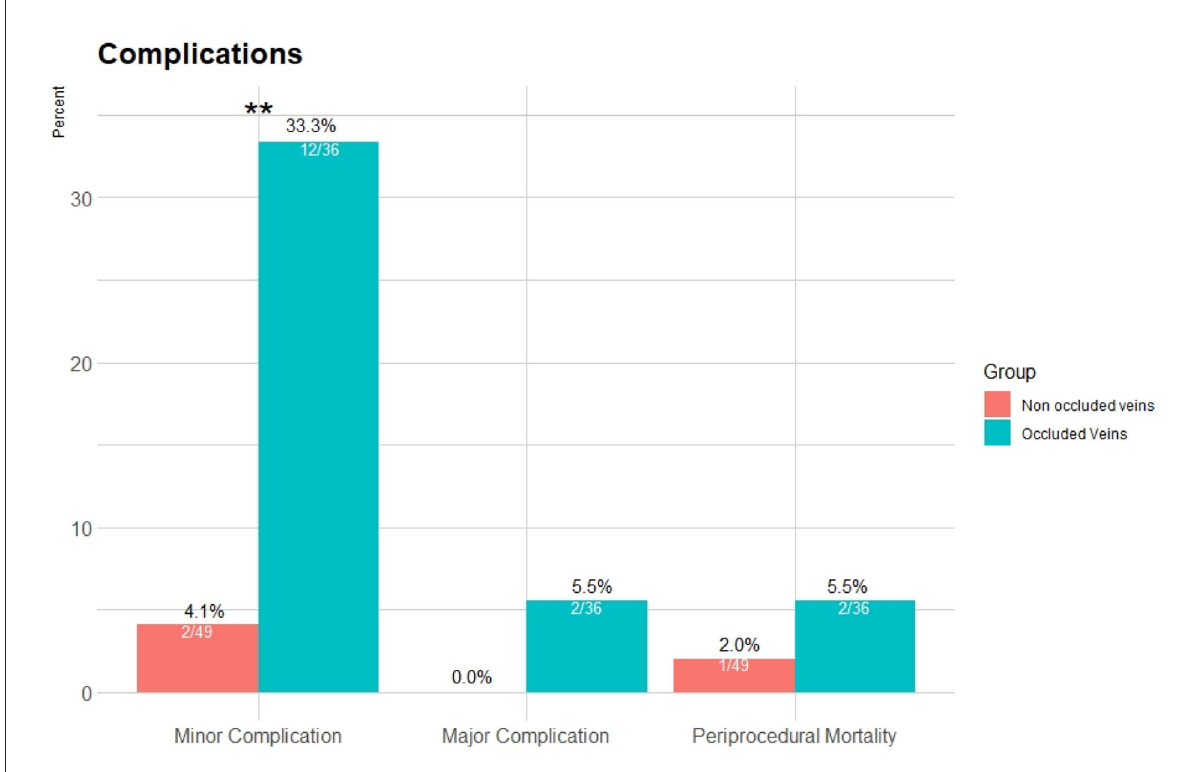
FIGURE3 Complication rates for the occluded and non-occluded vein groups. Major complications were exclusive for the occluded vein group (2 patients), and minor complications were more frequent ( p < 0.001). Periprocedural death during follow-up was similar ( p = 0.38). ** p <